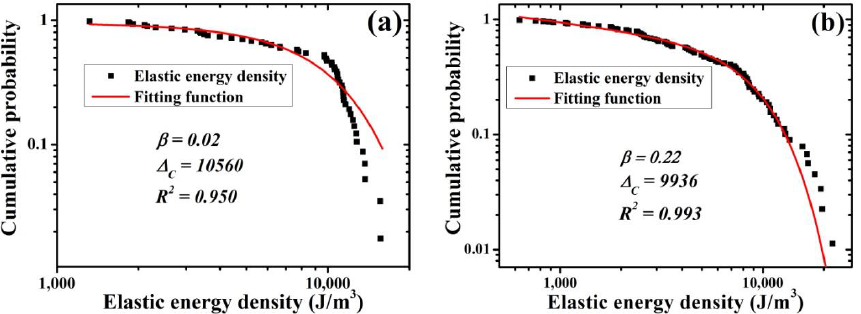
Figure 4. Cumulative probability distributions for the elastic energy density at the strain rates of 2 × 10 −3 , and 2 × 10 −4 ·s −1 , respectively. The red lines are fitted by Equation